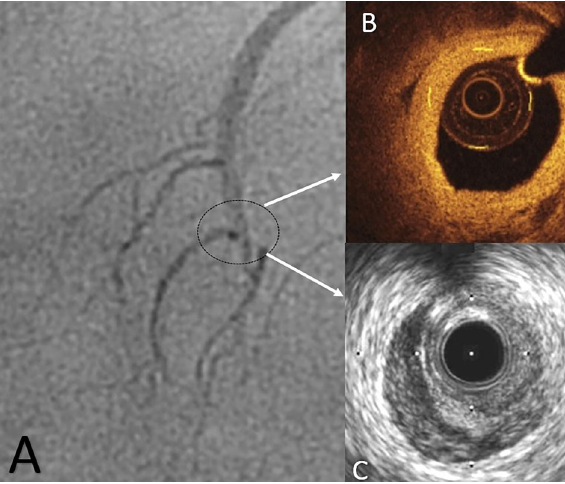
Figure 4. Pre-percutaneous coronary intervention images of a 52-year-old female. A , Clear coronary angiographic image. The black circle shows suspected coronary artery dissection. B , Frequency domain optical coherence tomographic image of the suspected part which clearly shows the lumen. Minimum lumen diameter: 2.08 ± 0.09 mm, minimum lumen area: 3.25 ± 0.01 mm 2 . C , Intravascular ultrasound image of the suspected part which clearly shows the lumen. Minimum lumen diameter: